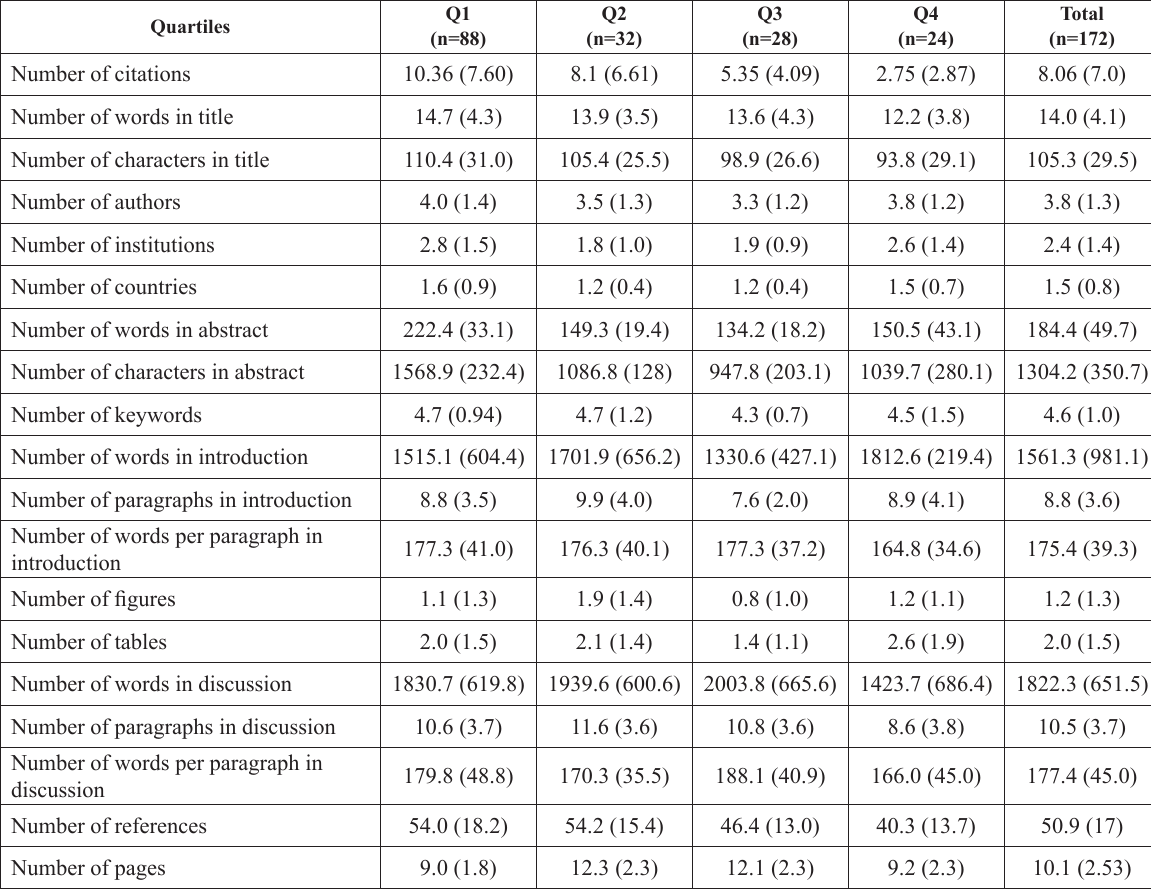
Table 1. Descriptive statistics of the articles of the selected journals in different quartiles